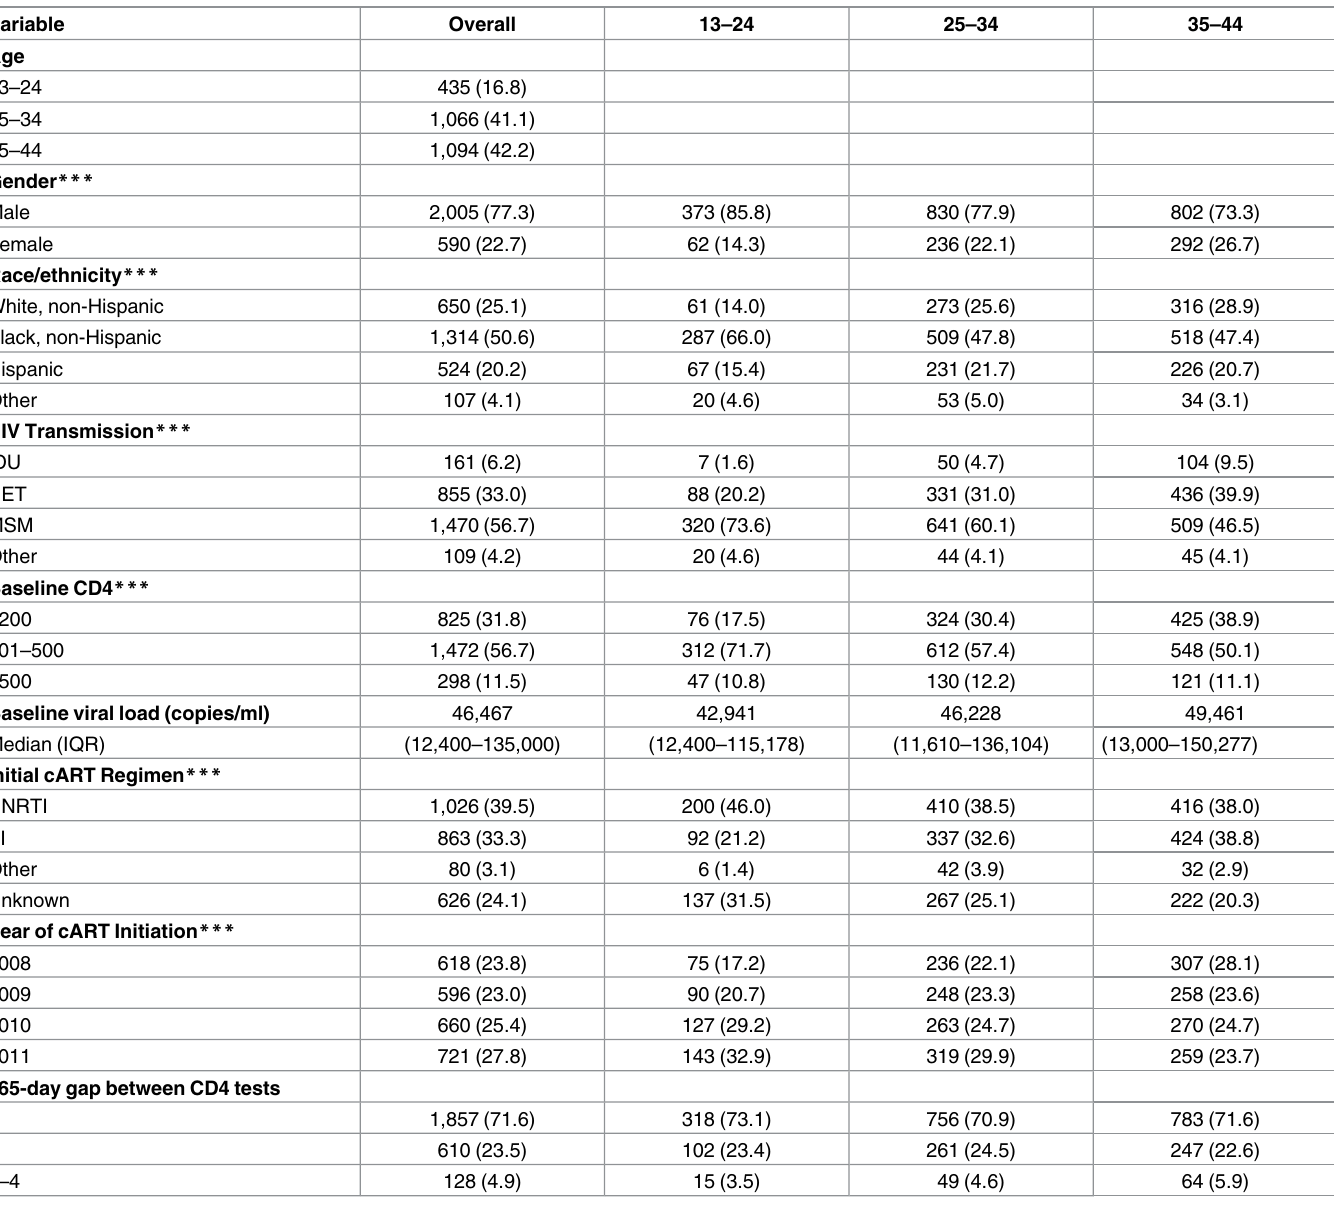
Table 1. Sample Description, Overall and by Age